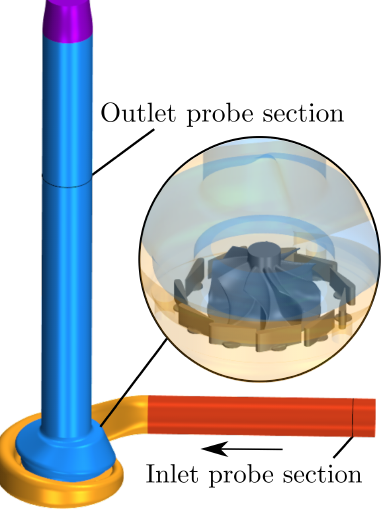
Figure 2. CFD domain